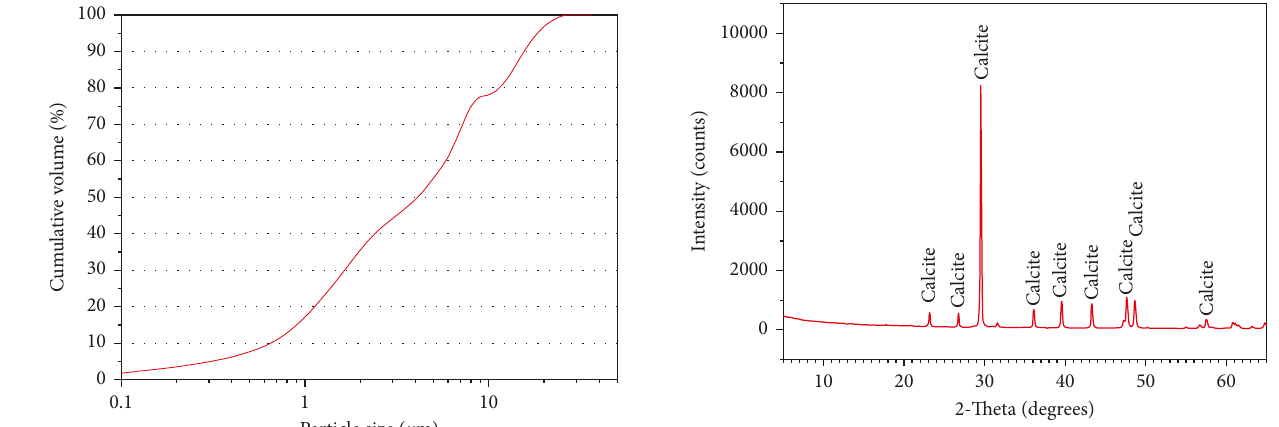
Figure 4: XRD pattern of limestone